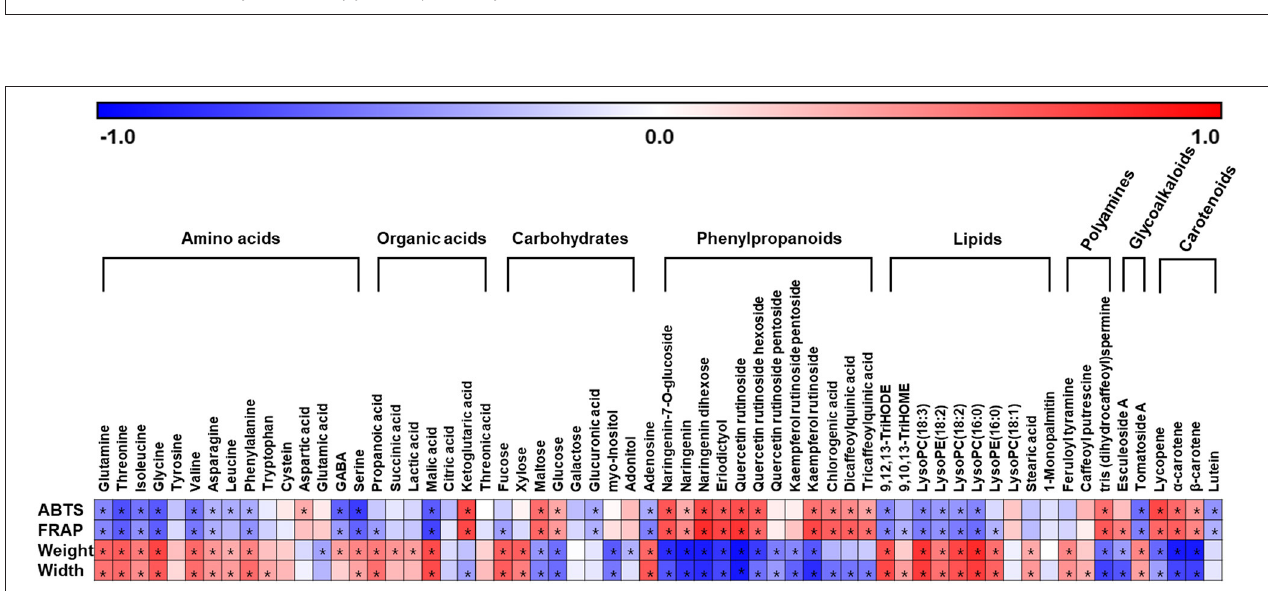
FIGURE 4 | Schematic diagram of the metabolic pathway and relative levels of metabolites in five types of tomato. The relative levels are shown as fold-changes normalized using the average of all values. The metabolic pathway was modified based on the KEGG database (http://www.genome.jp/kegg/). C, chal tomato; T,